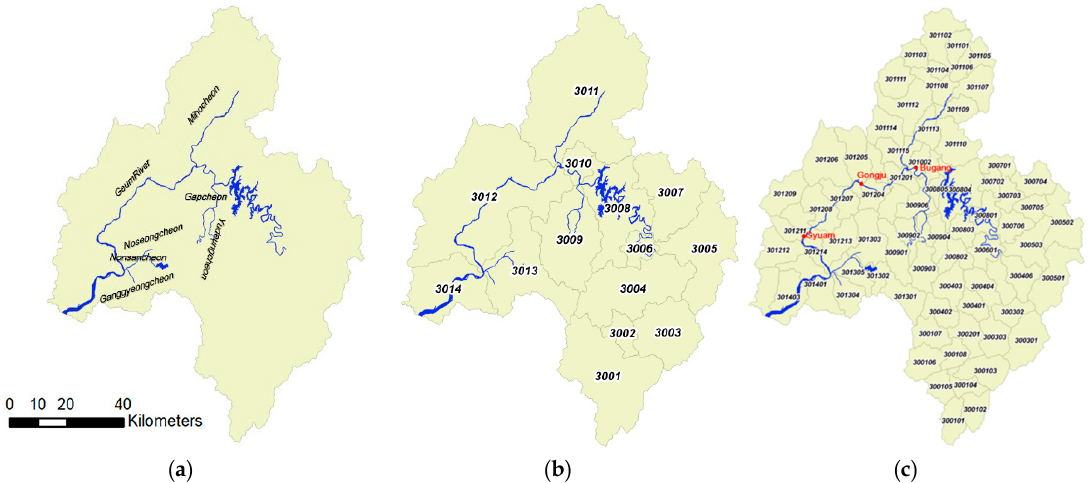
Figure 4. Large, medium, and standard watersheds of the Geum River Basin. ( a ) Large; ( b ) Medium; ( c ) Standard.